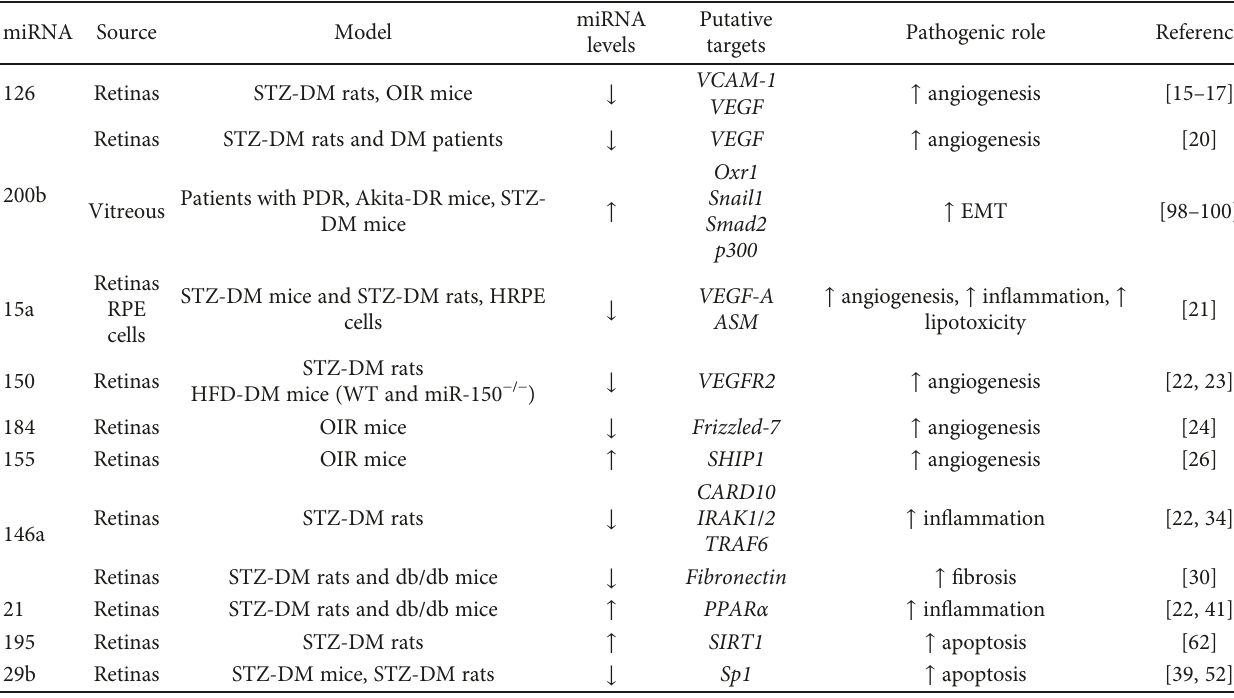
Table 2: MicroRNAs Involved in Diabetic Retinopathy.